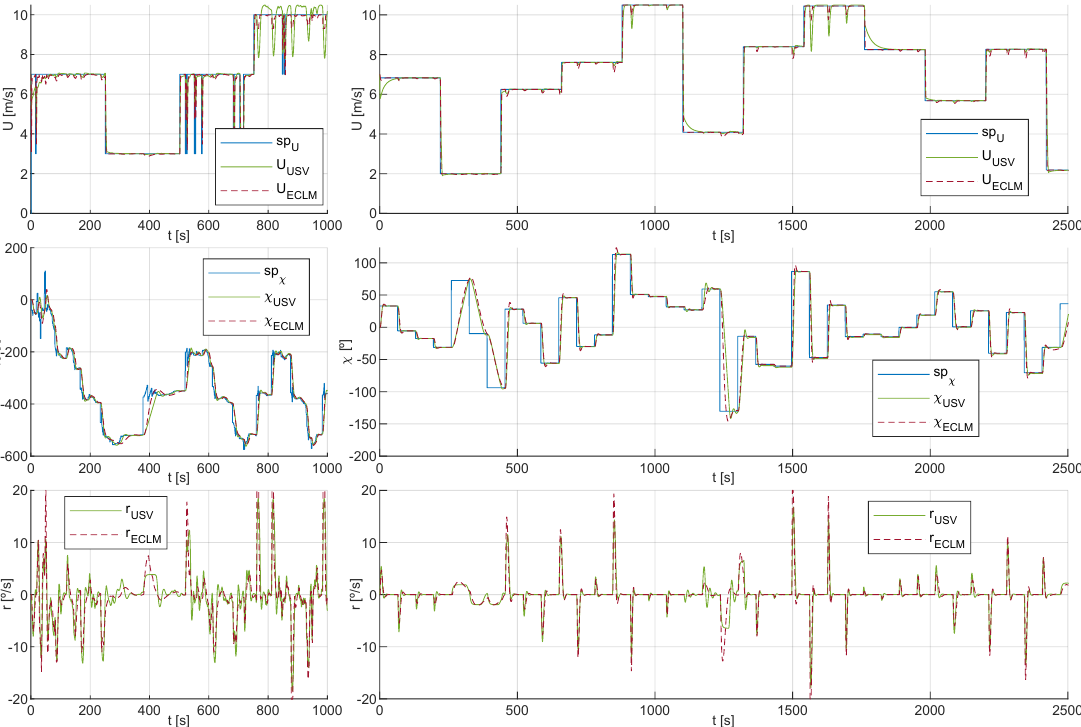
Figure 8. Time series obtained through numerical simulations with the unmanned surface vehicle (USV), Equations (1), (3) and (5), versus ECLM (28). Two time series: identification and